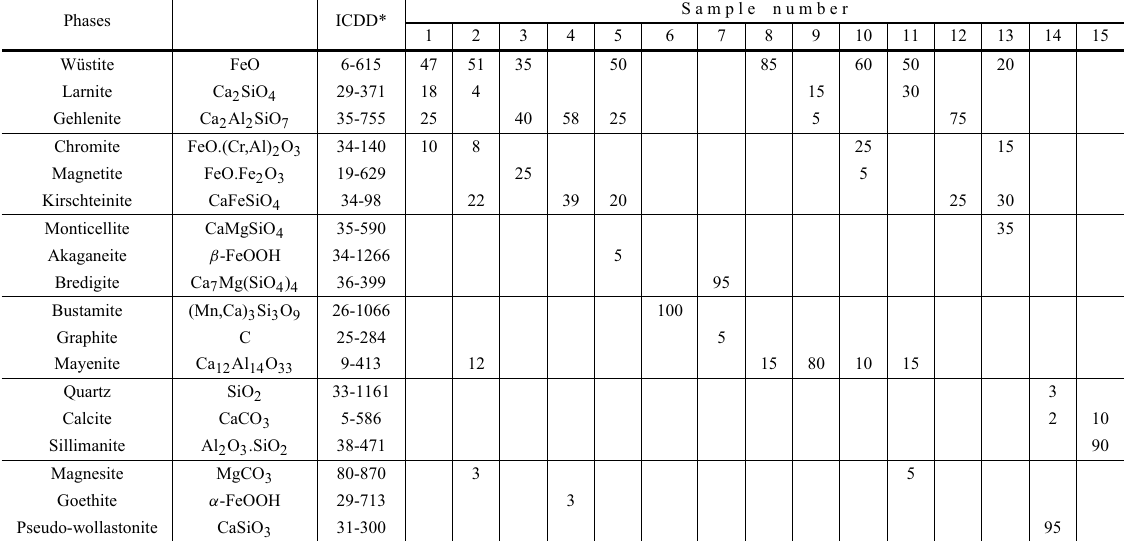
Quantitative analyses of slag phases (in percentage) by X-ray diffraction (powder method) including (i) the list of the detected phases in the analyzed steel slag, (ii) the ICDD (International Centre for Diffraction Data) card file for XRD and (iii) the stequiometric formula.